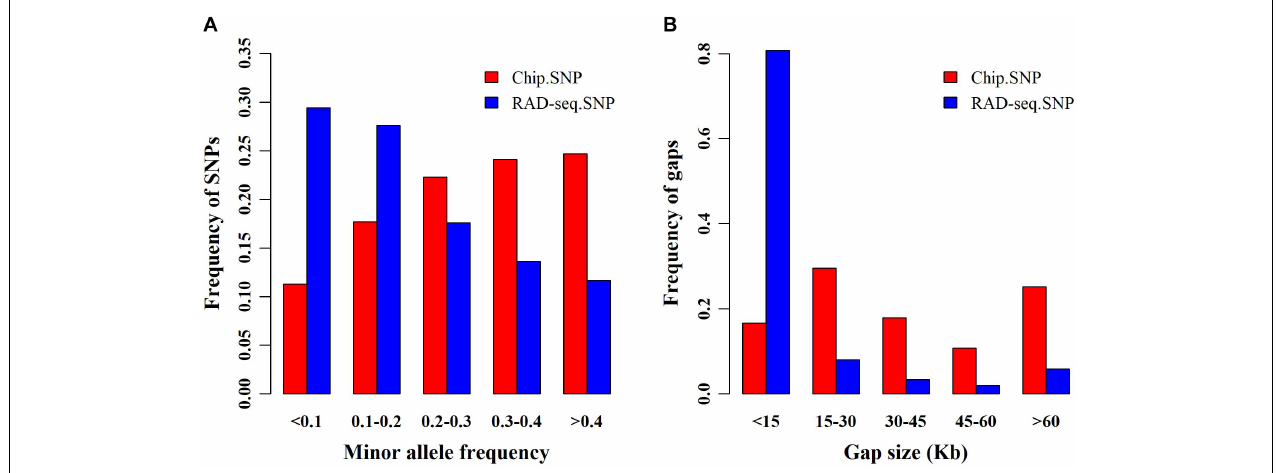
FIGURE 1 | Minor allele frequency (MAF) and distance between single nucleotide polymorphisms (SNPs). (A) Frequency of SNPs in different MAF classes for restriction site associated DNA sequencing (RAD-seq) and SNP chip assays. (B) Frequency distribution of the distance between adjacent SNPs for RAD-seq and SNP chip assays. TABLE 1 | The estimated heritability of birth weight for Yorkshire and Landrace with different sources of information. Population Information Number of